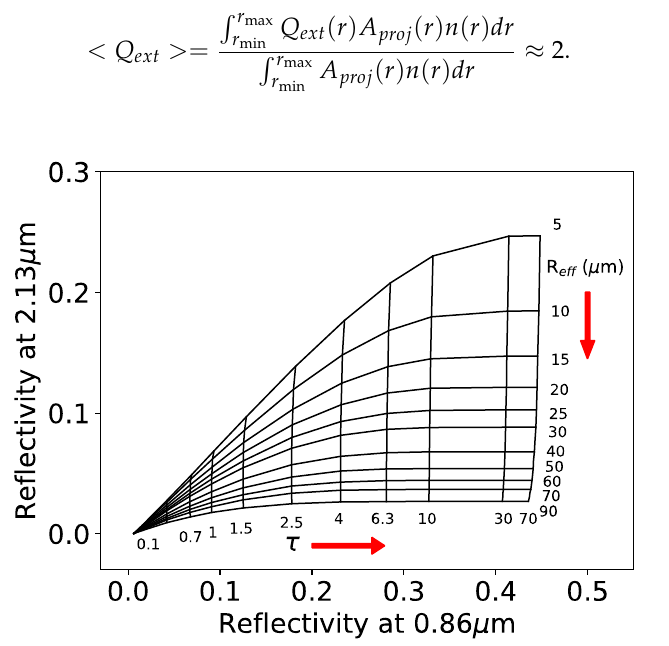
Figure 8. Schematic diagram illustrating the principle of the Nakajima–King bi-spectral method [42] for simultaneous retrieval of cloud optical thickness and effective radius. The look-up table shown in the diagram is generated with a solar zenith of 60 ◦ , a viewing zenith angle of 45 ◦ , and a relative azimuthal angle of 105 ◦ for a severely roughened ice particle model. Courtesy of Yi Wang (Texas A&M University).